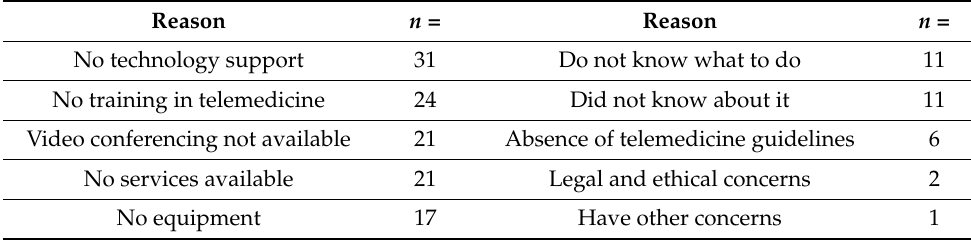
Table 3. Reasons given for not using telemedicine ( n =